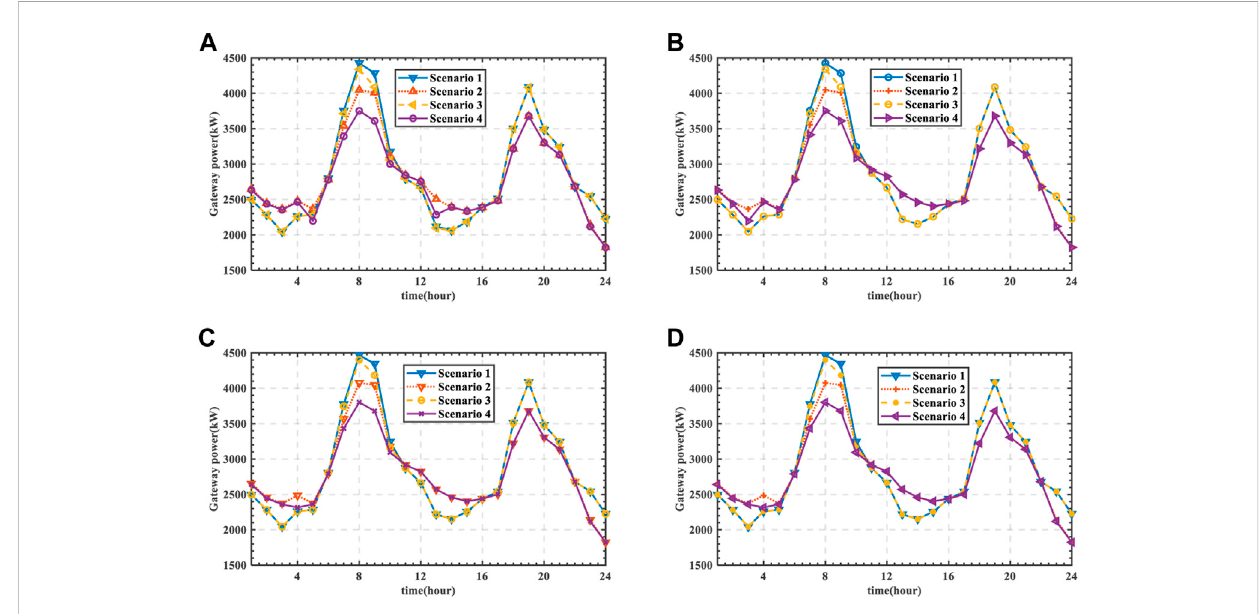
FIGURE 9 Gateway power of DN for the shortest